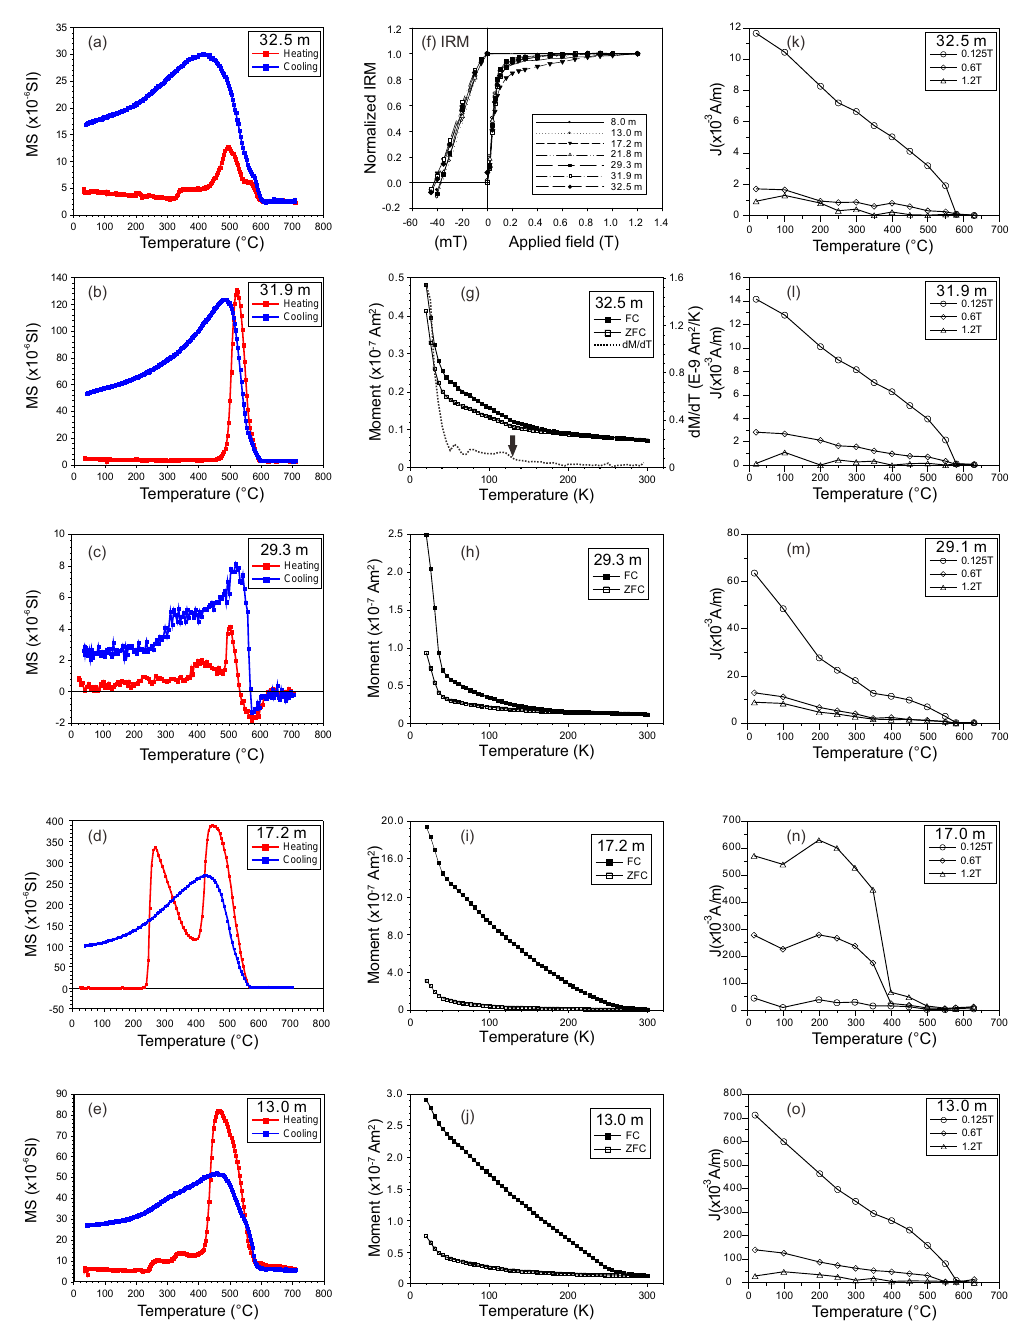
Figure 5. Rock magnetic data of samples from the Youganwo Fm and Huangniuling Fm. Panel ( a–e ): temperature dependence of magnetic susceptibility (MS) of samples from the Huangniuling mudstone (a, b) and from the uppermost brown grey shale (c) and the oil shale (d, e) of the Youganwo Fm during a heating–cooling cycle between room temperature and 700 ◦ C. Panel ( f ): IRM acquisition and the subsequent demagnetization in a backward DC field. Panel ( g–j ): zero-field-cooled (ZFC) and field-cooled (FC) low-temperature measurements of the representative samples. The arrow in (g) marks the subdued Verwey transition. Panel ( k–o ): thermal demagnetization of the composite IRM that was acquired along z , y , and x axes in a field of 1.2, 0.6, and 0.125 T ,